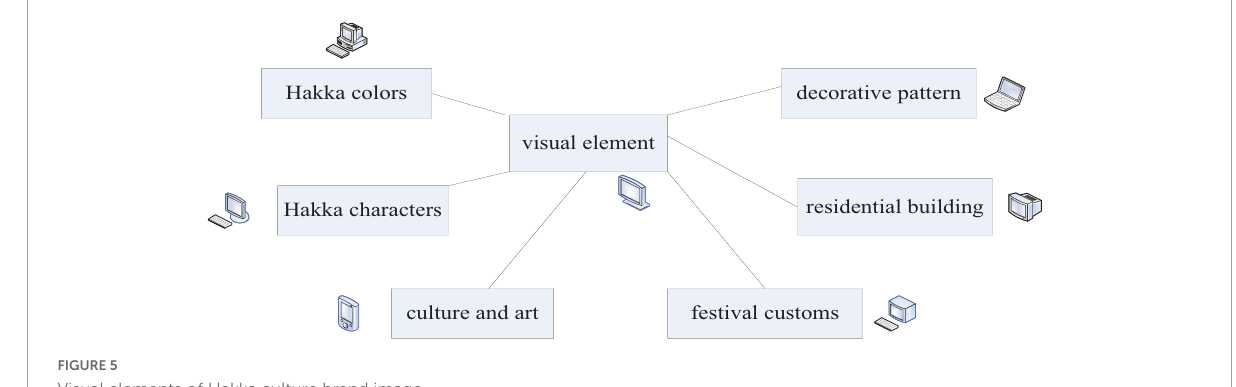
FIGURE5 Visual elements of Hakka culture brand image.